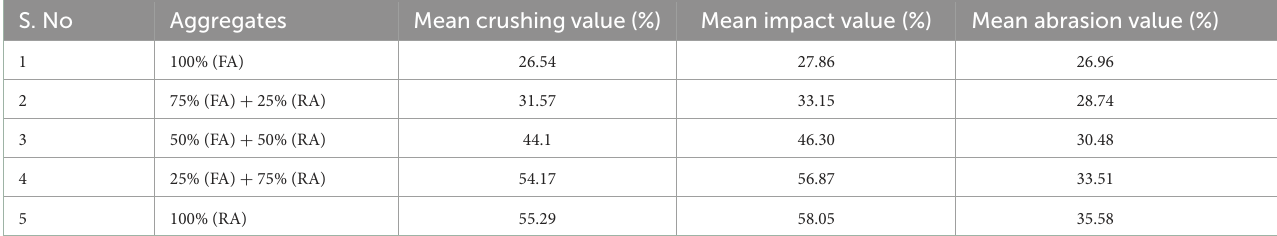
TABLE 2 Crushing value, impact value, and abrasion value of C&D waste at different percentages of replacement. S.